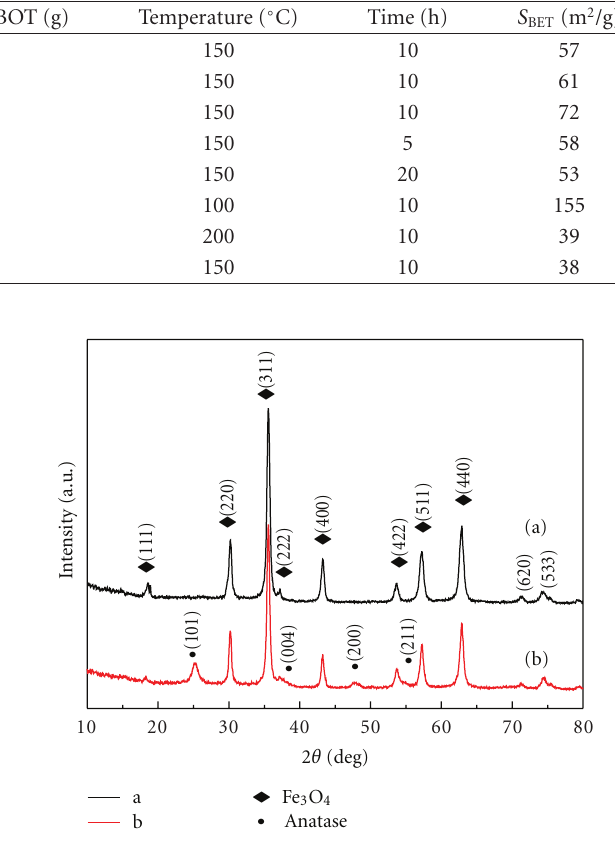
Figure 2: XRD pattern of (a) Fe 3 O 4 and (b) Sample B.